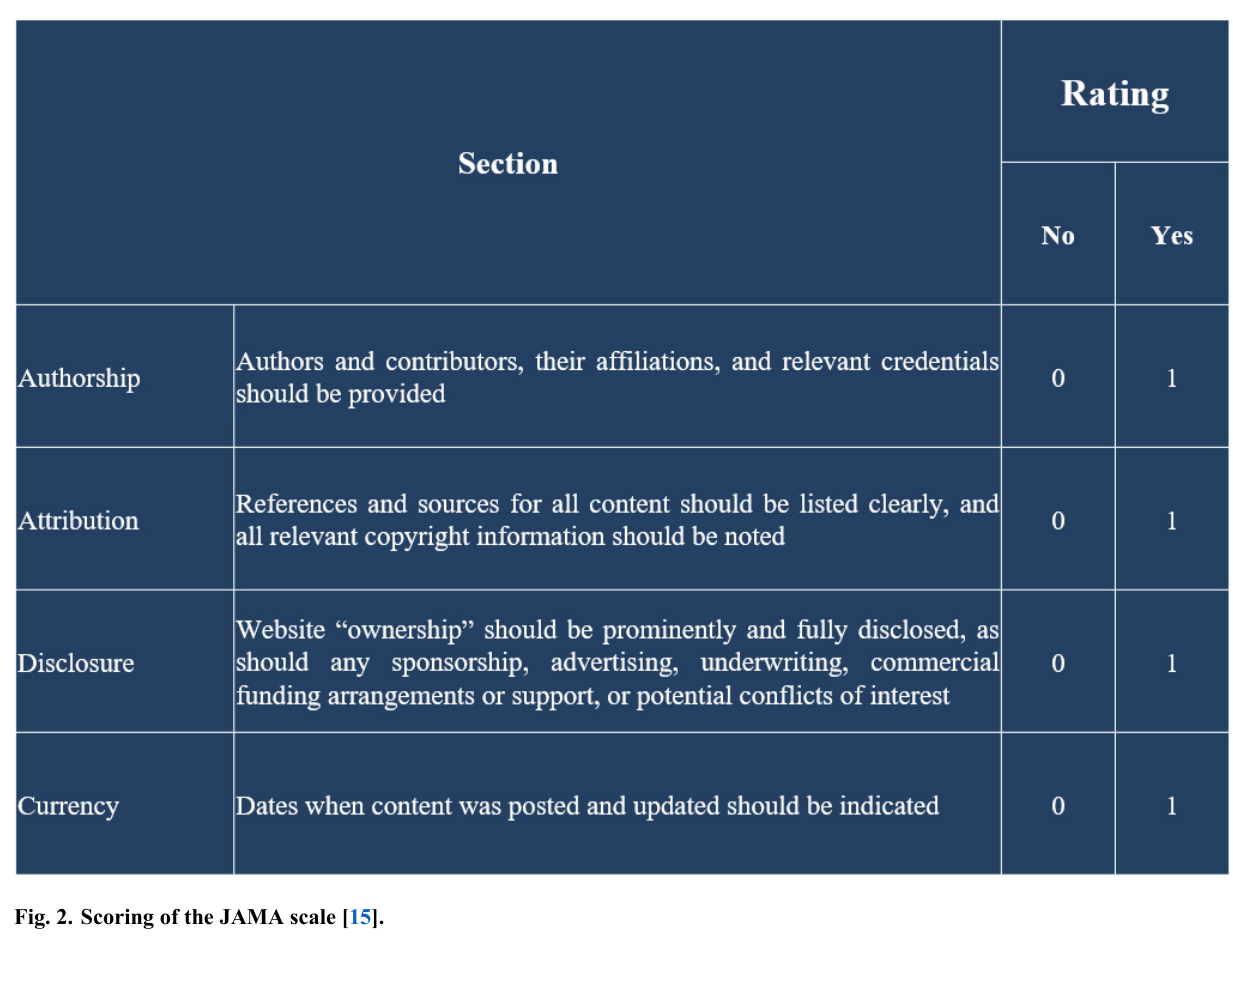
Fig. 2. Scoring of the JAMA scale [15].